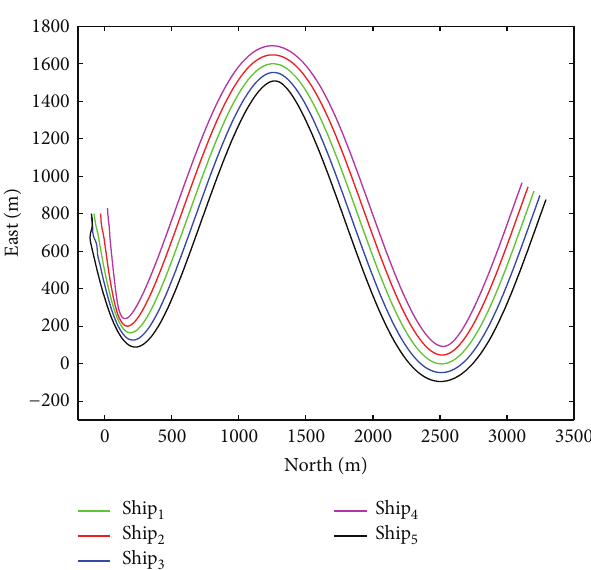
Figure 2: The formation trajectories in horizontal